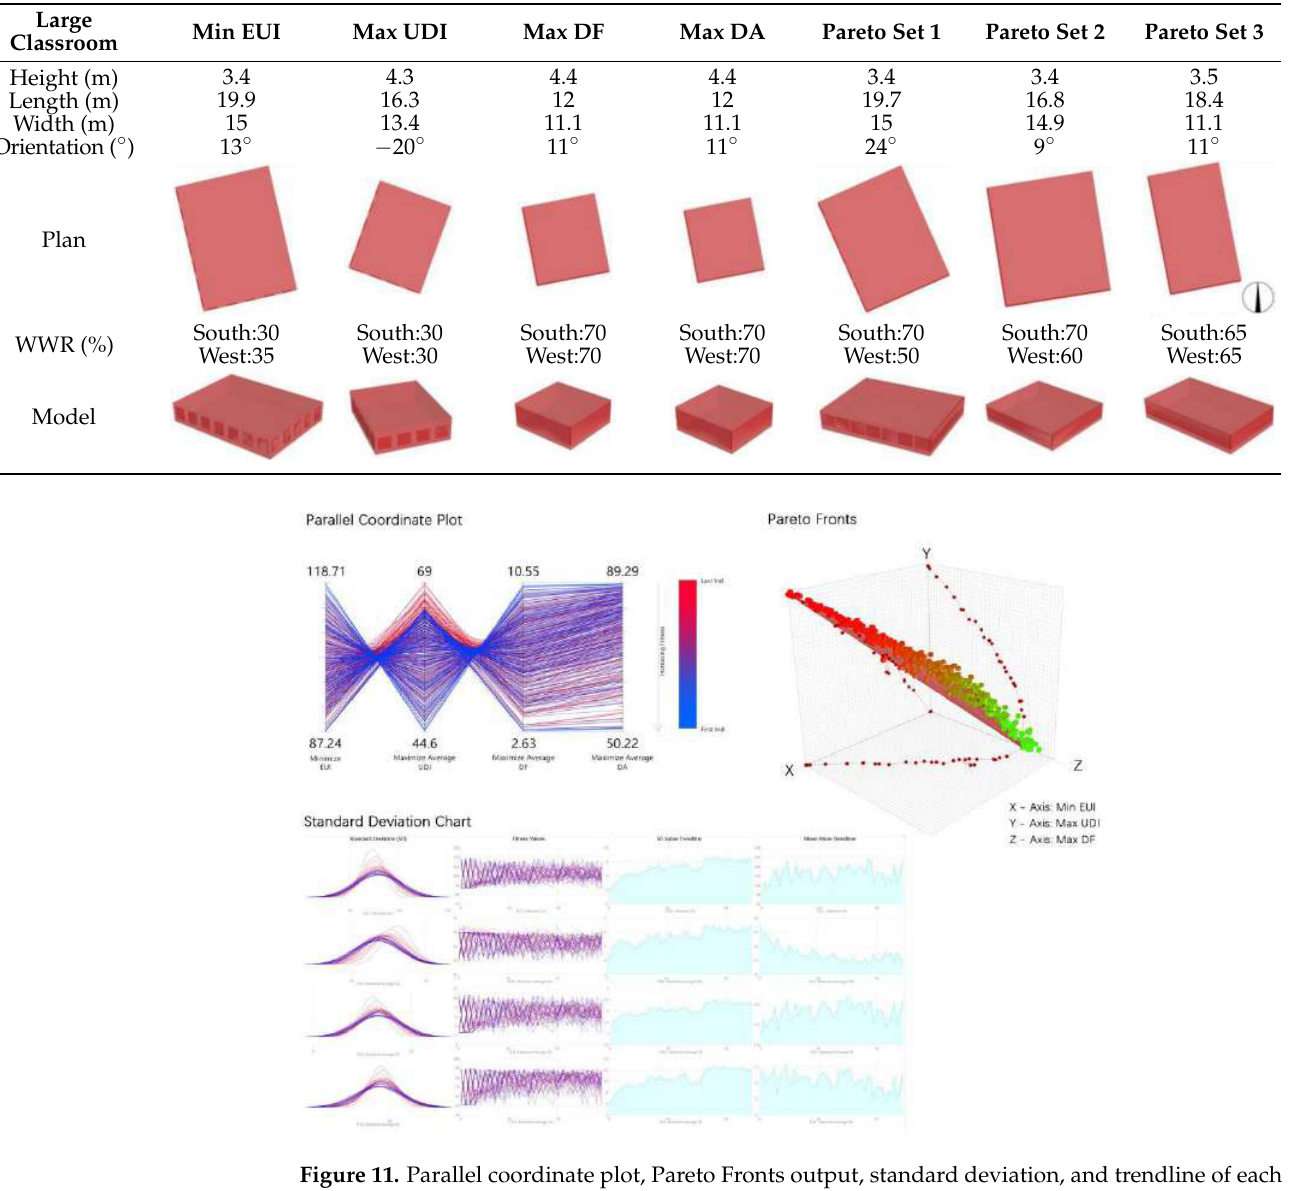
Figure 11. Parallel coordinate plot, Pareto Fronts output, standard deviation, and trendline of each index in large, west/south-oriented classrooms. index in large, west/south-oriented